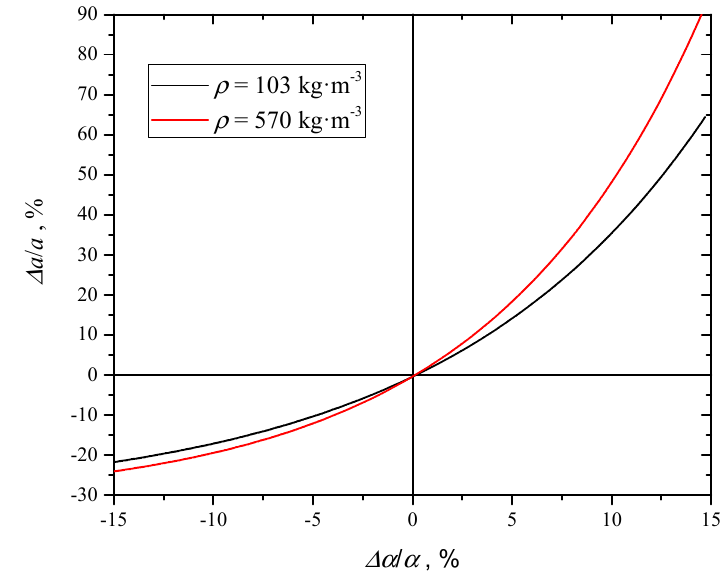
Figure 12. Relative deviation of a as a function of relative deviation of the thermal diffusivity of coated samples, at two different densities.